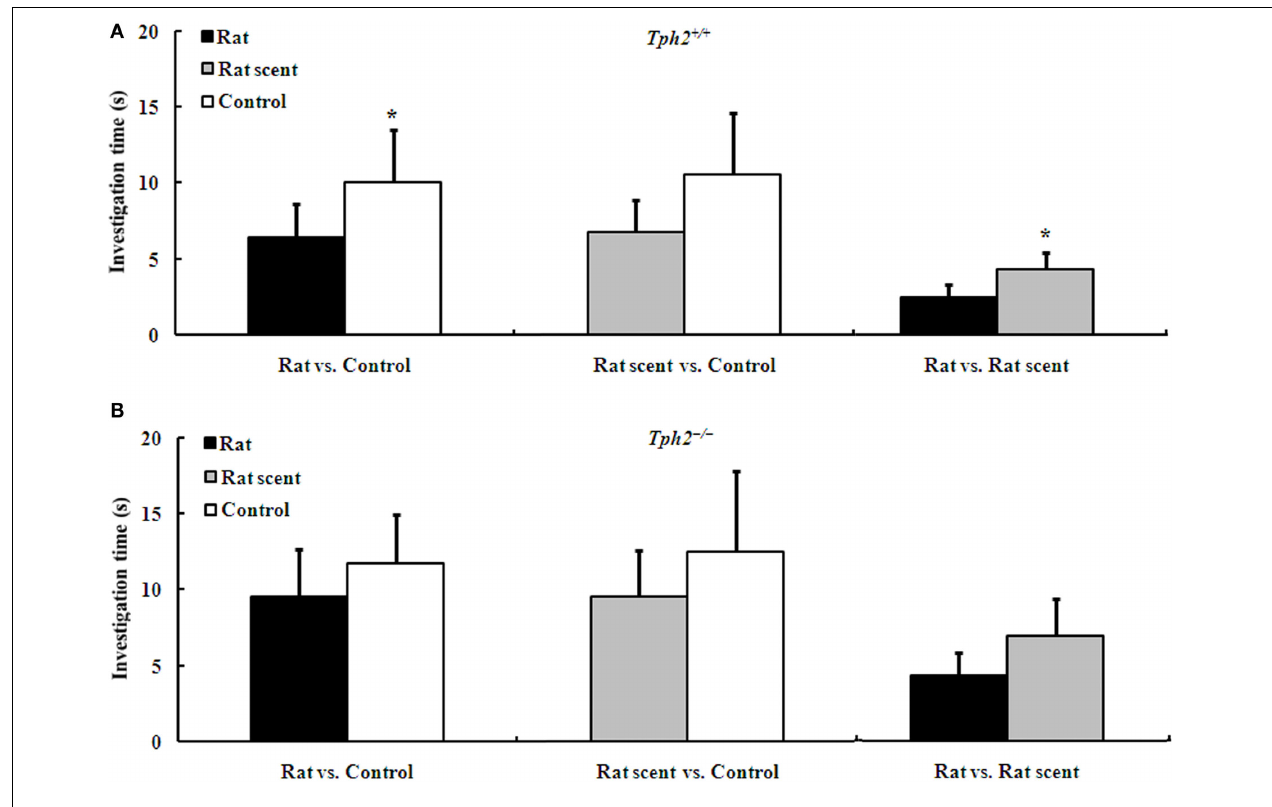
FIGURE 2 | Duration of the investigation (mean ± SE, n Rat = 7, n Rat scent = 8, n Control = 8) of Tph2 + / + female mice to male urine of different treatments during a 3-min choice test. (A) Comparison of investigation time of Tph2 + / + female mice to the urine from two of the